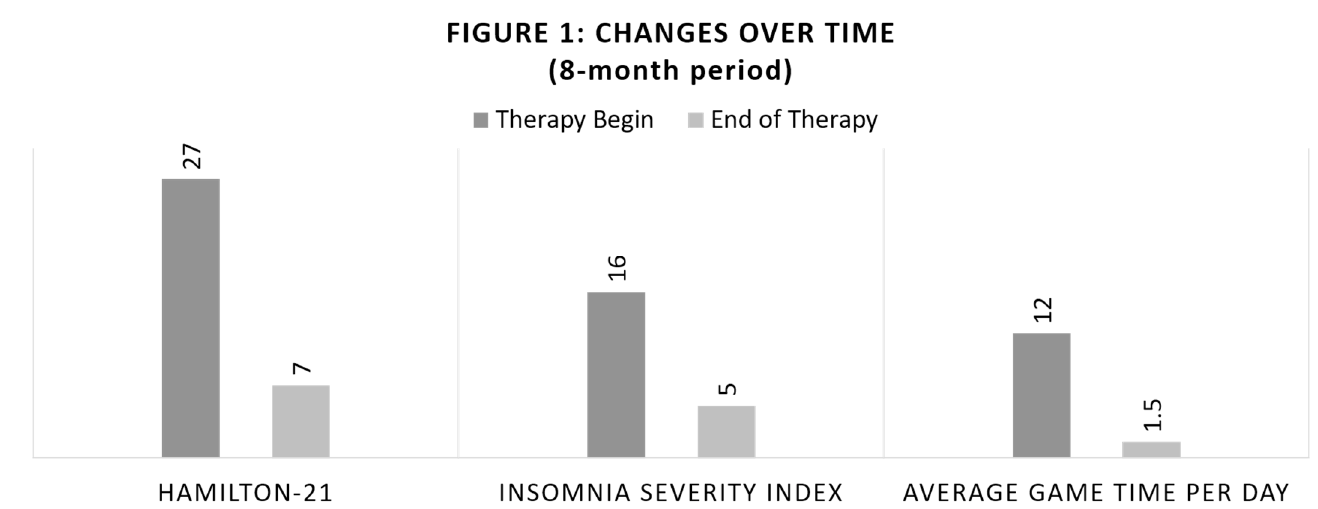
Figure 1. Changes over time (8-month period). Note: own depiction.